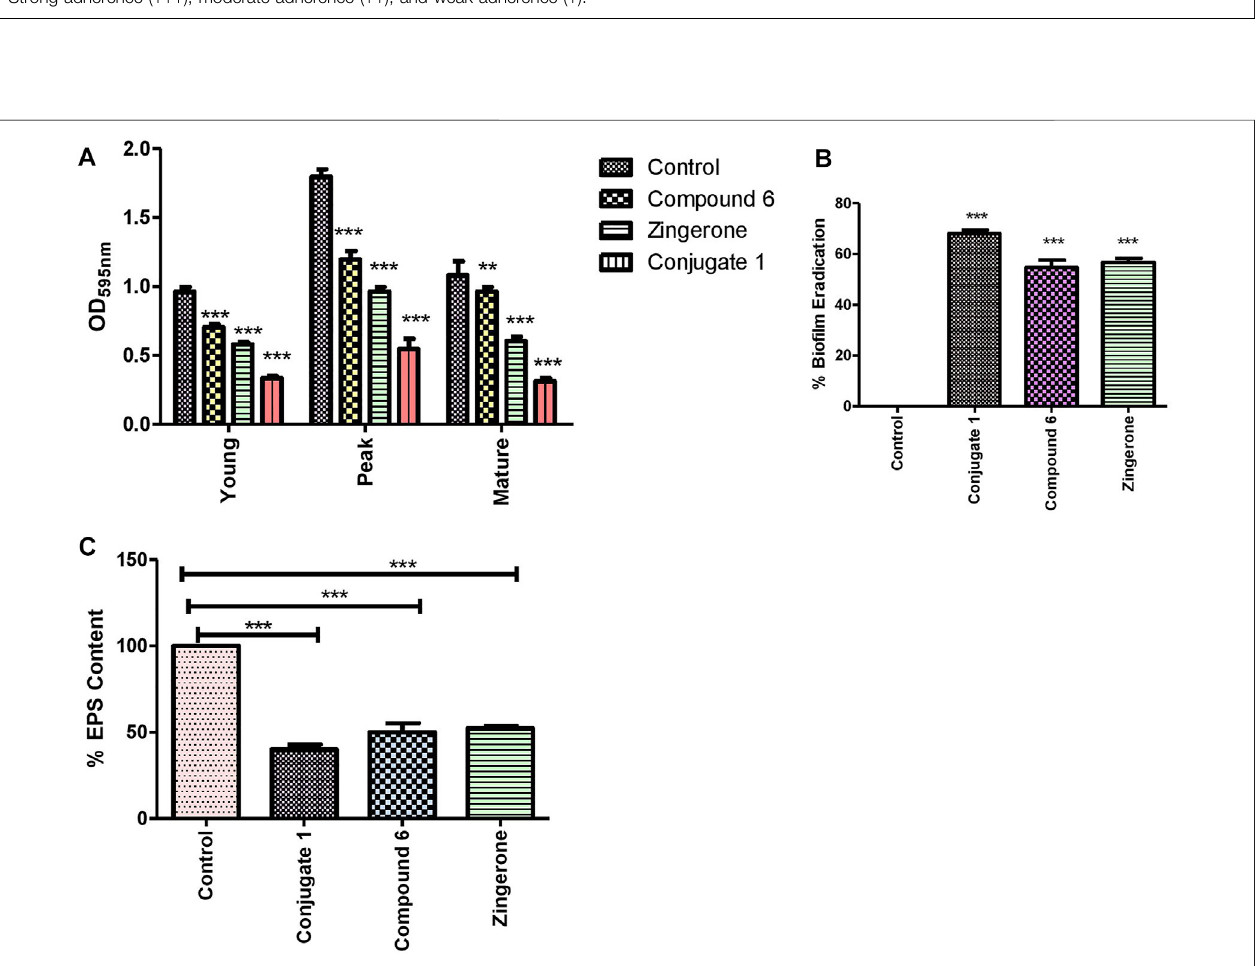
FIGURE 7 | (A) Inhibition pattern of P. aeruginosa bio fi lms (young, peak, and old), (B) percentage bio fi lm eradication as quanti fi ed by crystal violet assay, and (C) percentage EPS estimation of the bio fi lm matrix by using the Congo red binding assay in absence and the presence of sub-MIC of catechol – zingerone conjugate ( 1 ), Compound ( 6 ), and zingerone